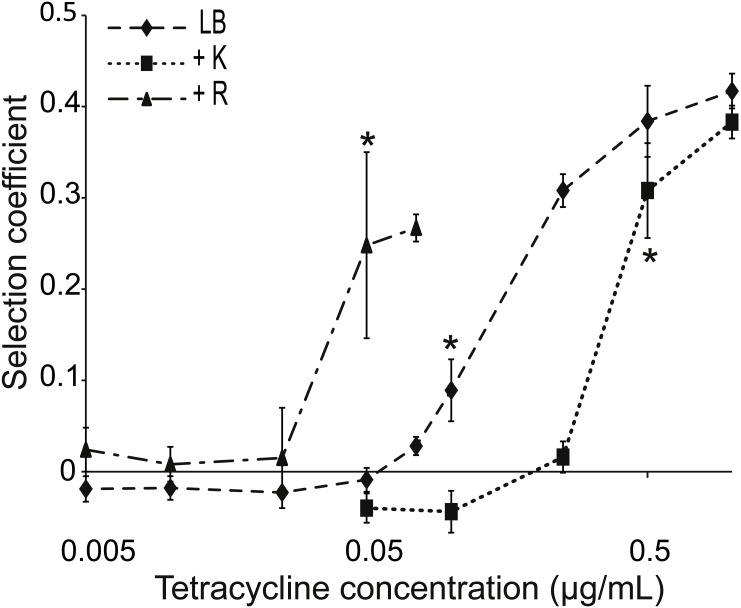
Competition between strains of different potential to resist tetracycline.Competition between tetracycline resistant (AH201, Tethigh) and susceptible (AH214, Tetlow) strains of E. coli in different concentrations of tetracycline with or without Kamba (K) or Roundup (R). Kamba was used at 1,830 ppm ae, Roundup at 311 ppm ae. Selection coefficients are presented as a function of tetracycline concentration, with positive values indicating a selection for the more resistant strain. Values are means of three independent experiments. To represent sampling uncertainty in the mean value for treatment groups we present error bars depicting standard errors (standard deviation/√n). * indicate the lowest tetracycline concentrations for each treatment where selection coefficients were significantly different from the -Tet/-herbicide treatment, based on a Bonferroni corrected contrast described in the ‘Materials and Methods’.